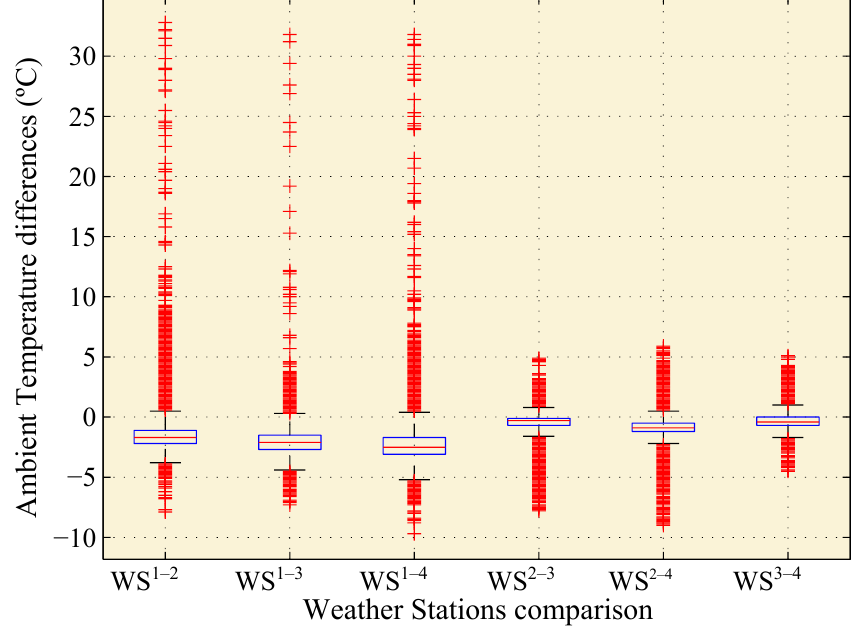
Figure 8. Box plots of ambient temperature differences between weather stations. Finally, in Figure 9, the same as in ambient temperature occurs in solar radiation. WS 1 obtains lower values than the others. In general, it is shown that the variability in the case of solar radiation is very